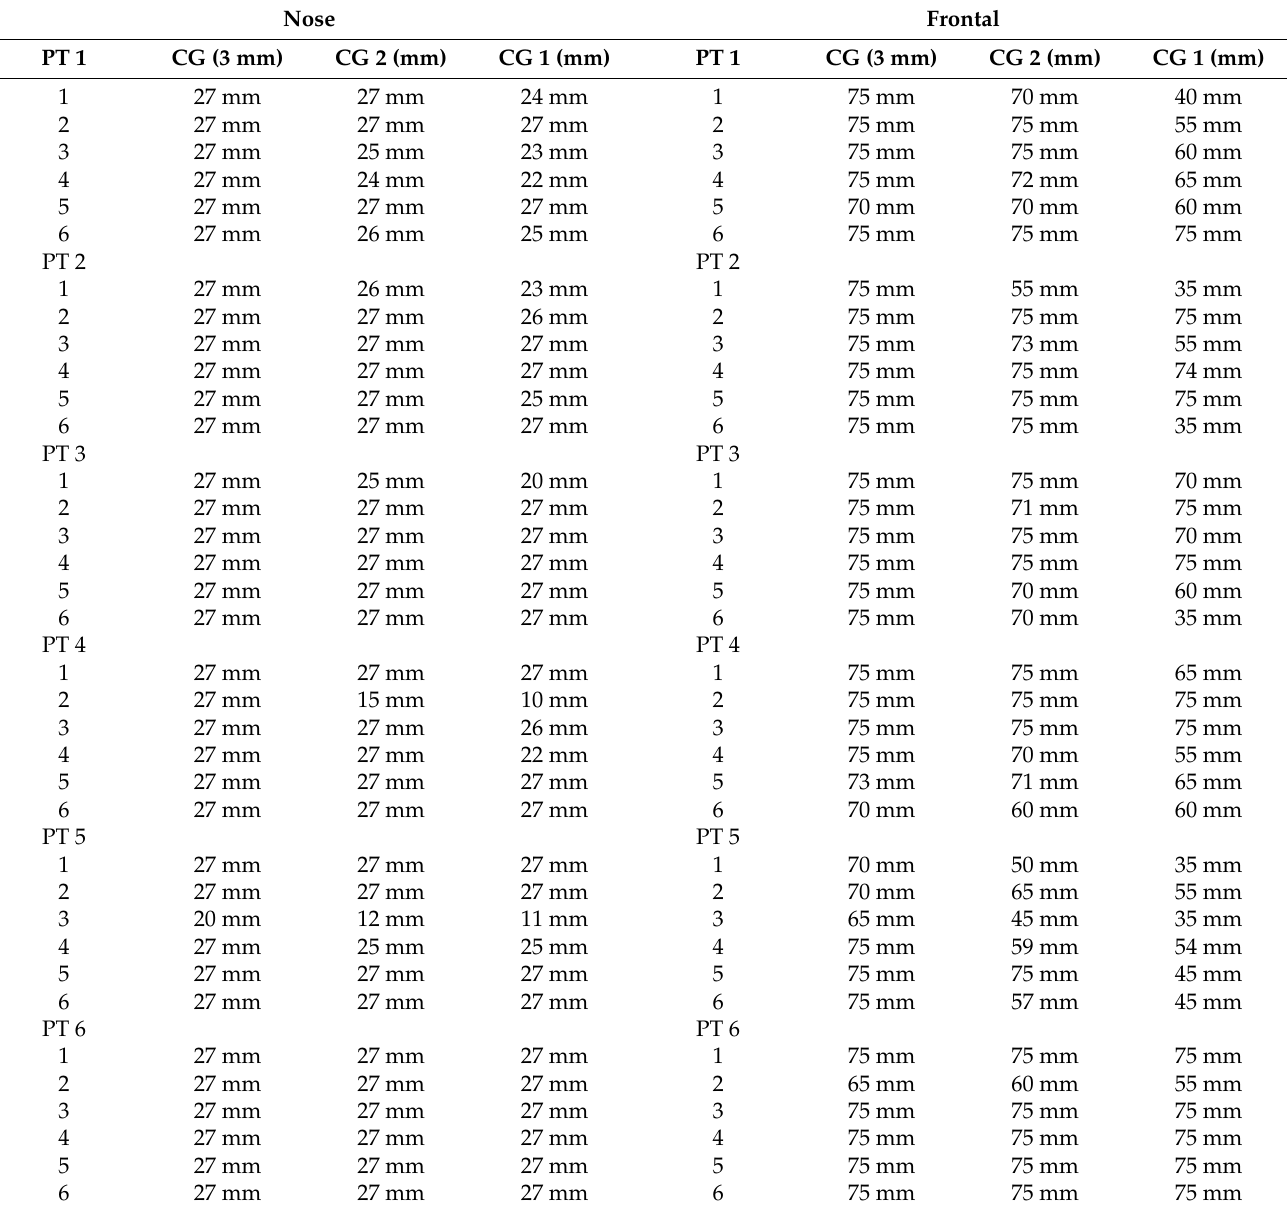
Table 1. Measurements taken from each recruited user. The left column shows the measurements for the nasal cut and the right column shows the measurements for the frontal cut. CG: cutting